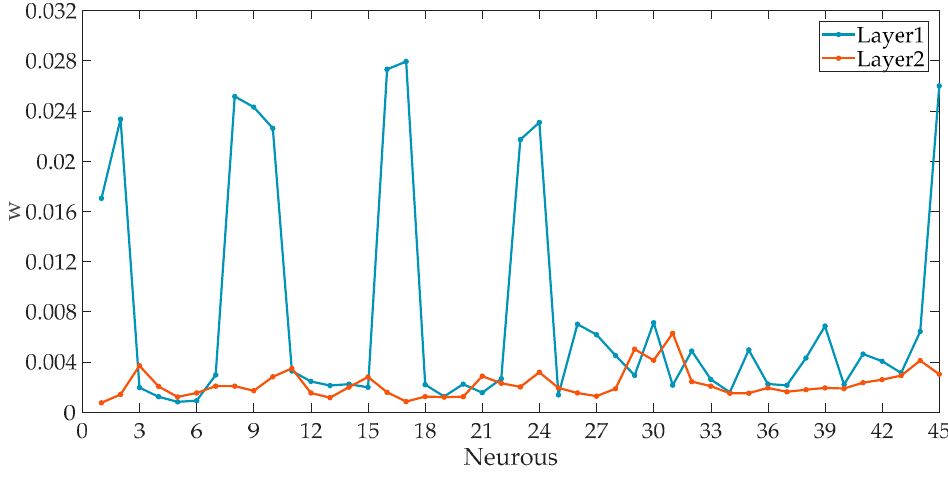
Figure 6. w of each neuron.